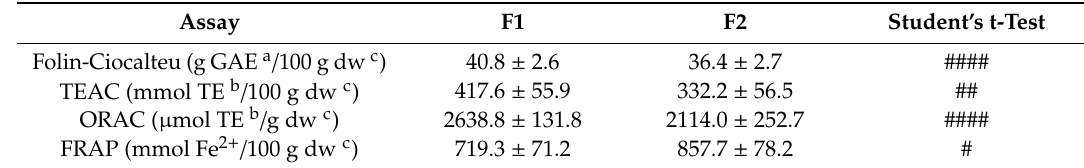
Table 2. Phenolic content and values for different antioxidant measurements performed with the formulations F1 and F2. Assay F2